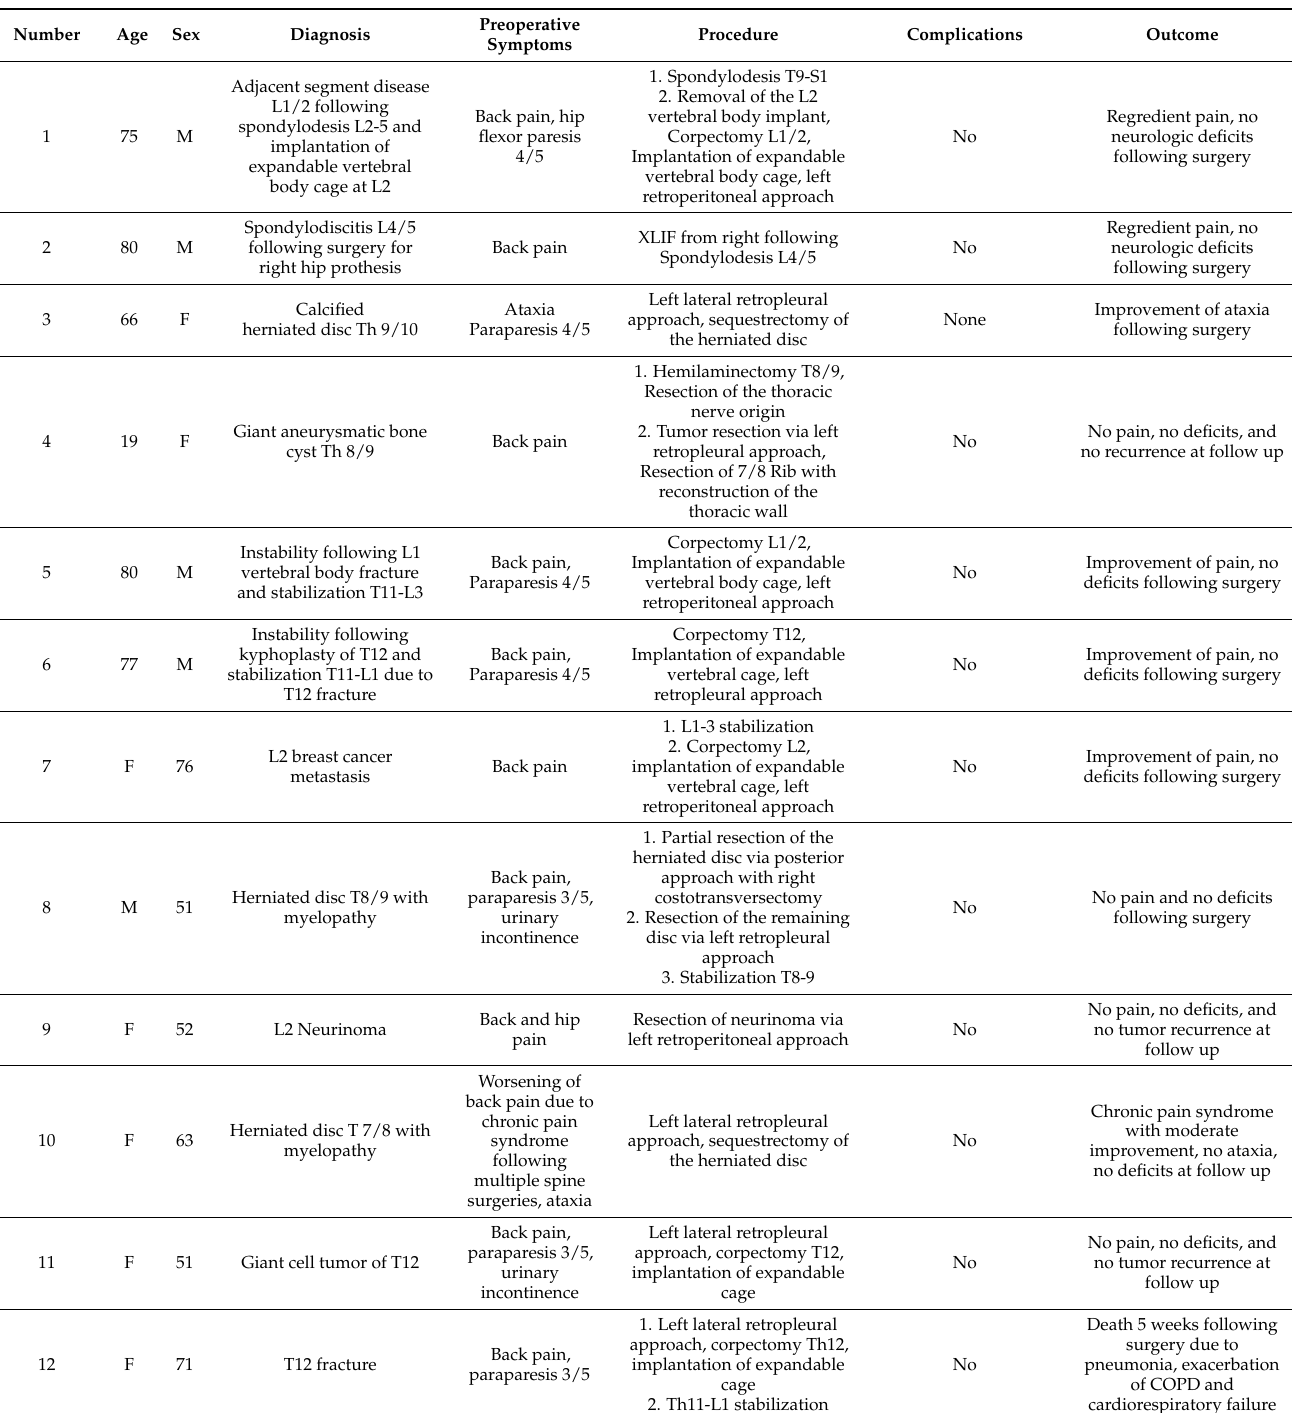
Table 1. Patient characteristics and clinical